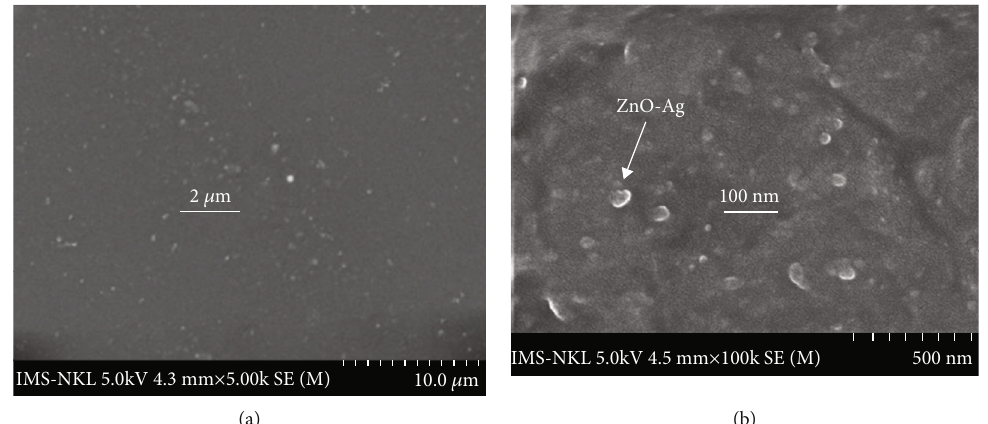
Figure 9: FE-SEM image of the photocurable acrylate urethane/ZnO-Ag nanocoating in surface (a) and in cross-section (b).